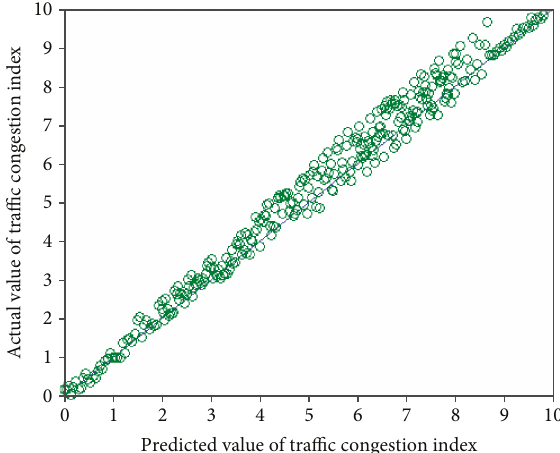
Figure 17: Scatter diagram of predicted values and actual values (sliding range